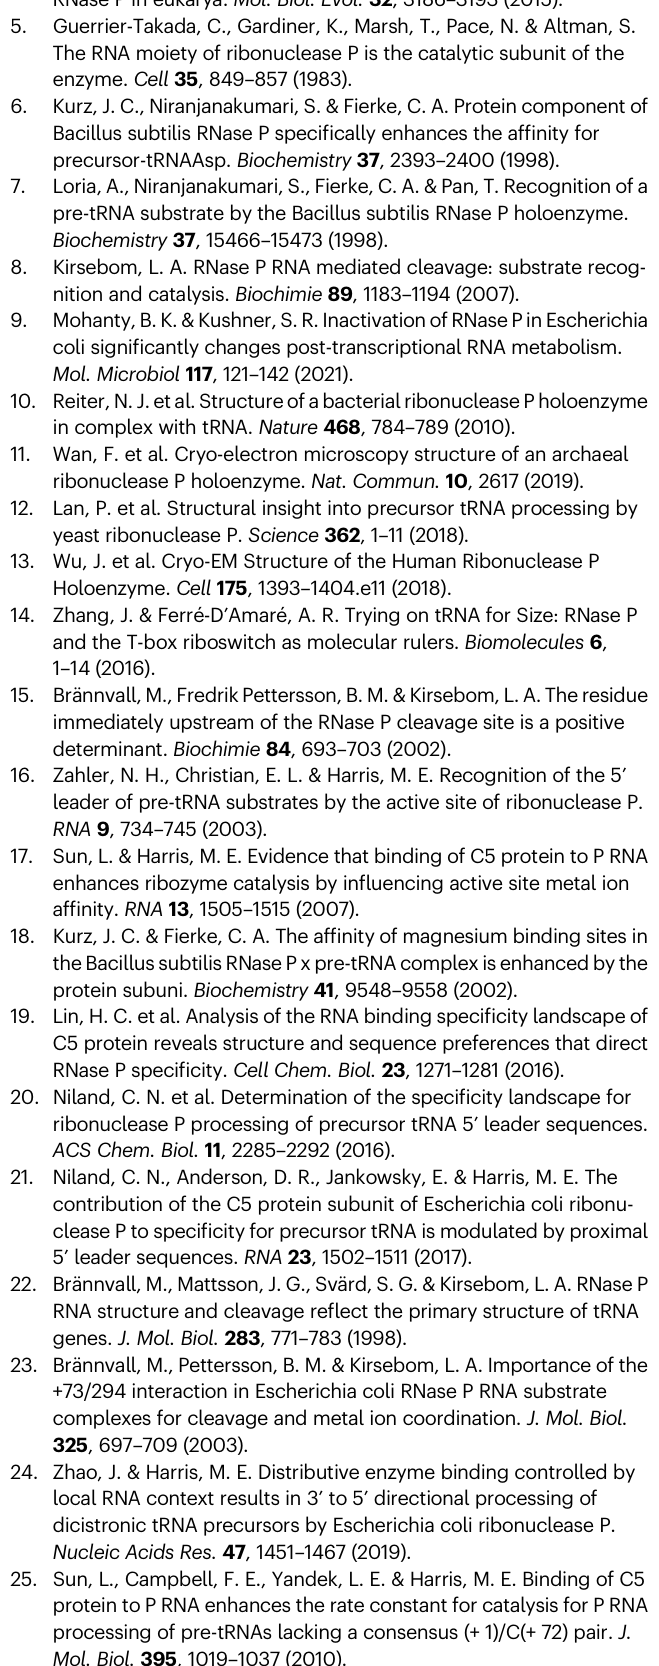
Figure panels depicting cryoEM maps or atomic models generated using ChimeraX 93 . Maps colored by local resolution were generated using RELION 3.1 87